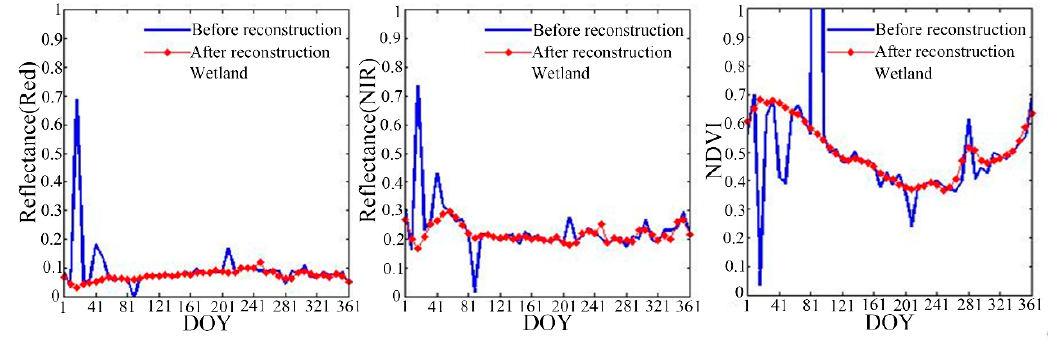
Figure 4. The VIIRS surface reflectances of the red and NIR bands as well as the NDVI before and after reconstructions at the Maun, Floodplain site (Lat: − 19.66°, Lon: 23.35°) in 2013.